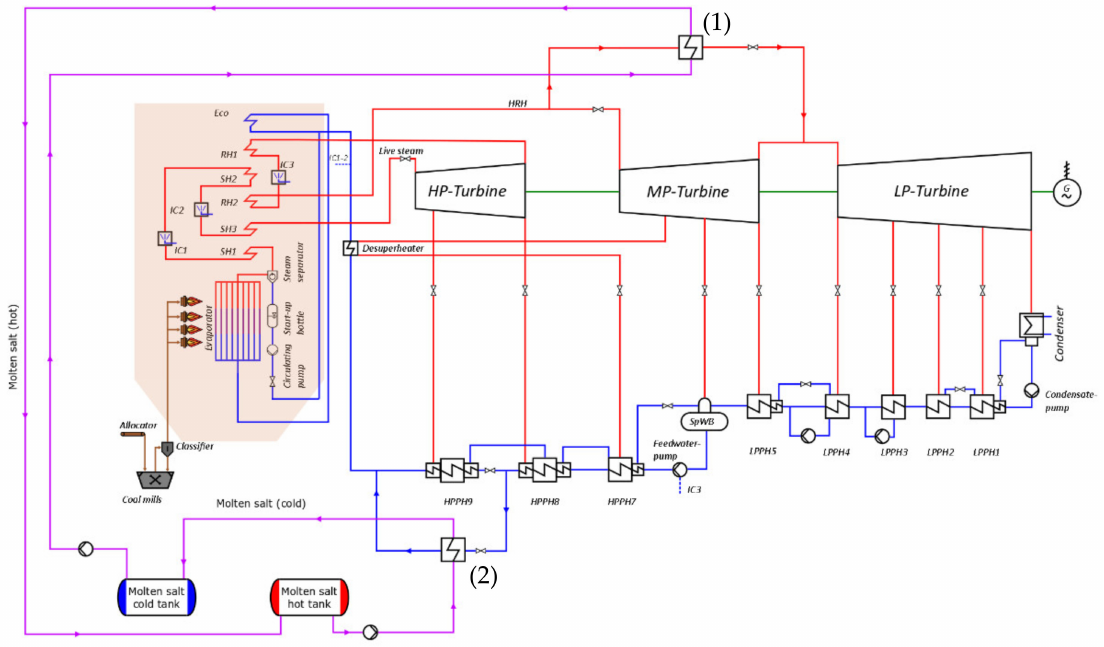
Figure 1. Thermal circuit diagram of an 800-MW power plant with molten salt storage (concept